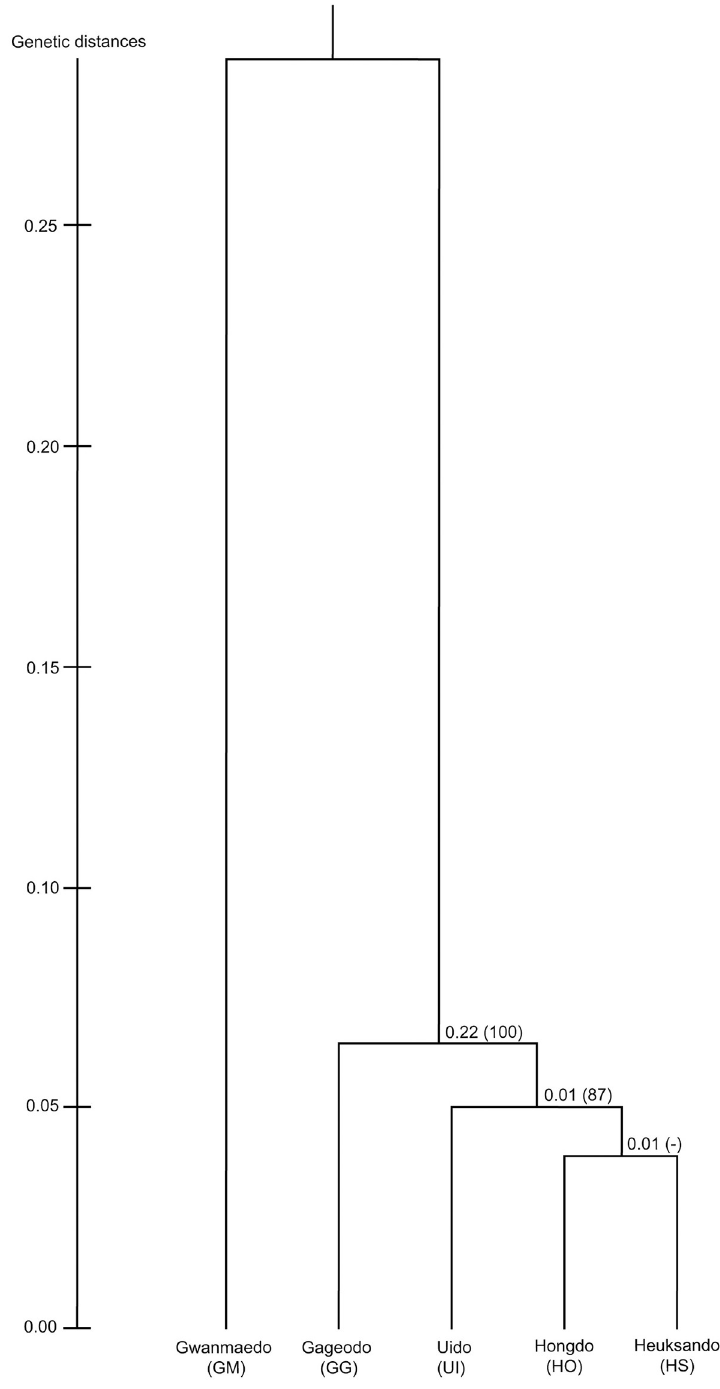
Fig 4. UPGMA dendrogram based on Nei’s genetic distance. Numbers above branches are indicated genetic distances. Bootstrap values are shown in parentheses, and hyphen indicates a less than 50% bootstrap value.